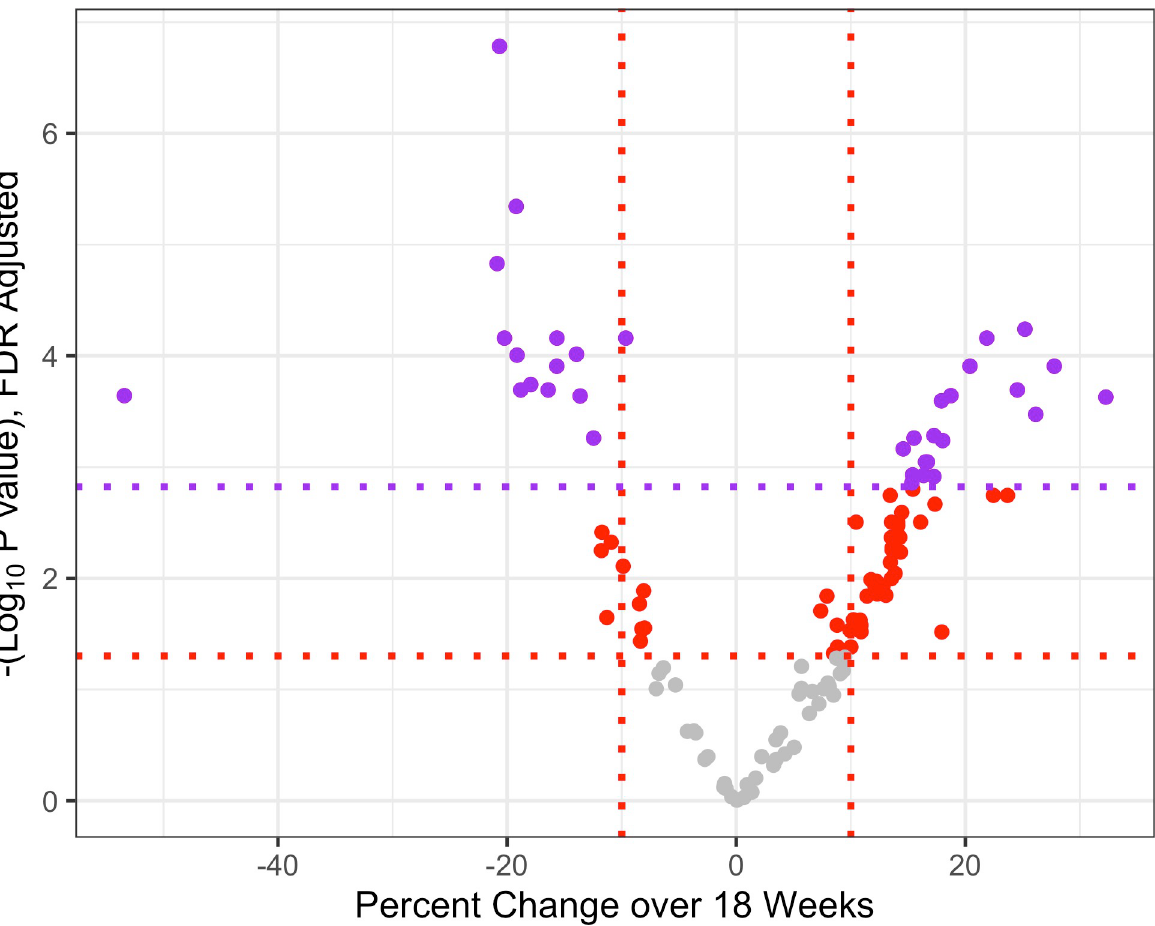
Fig 1. Volcano plot of miRNA associated with GA, scaled to 18 weeks of pregnancy. Red vertical dotted lines indicate -10% and 10% change over 18 weeks. Red and purple horizontal dotted lines indicate FDR-adjusted and Bonferroni-adjusted significance thresholds,